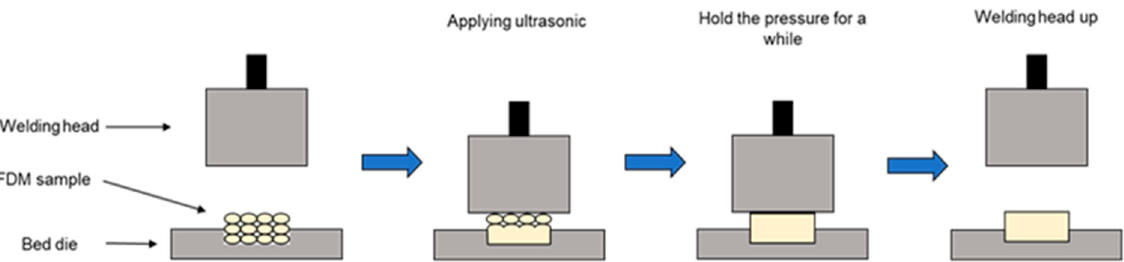
Figure 3. Schematic diagram of ultrasonic strengthening process .